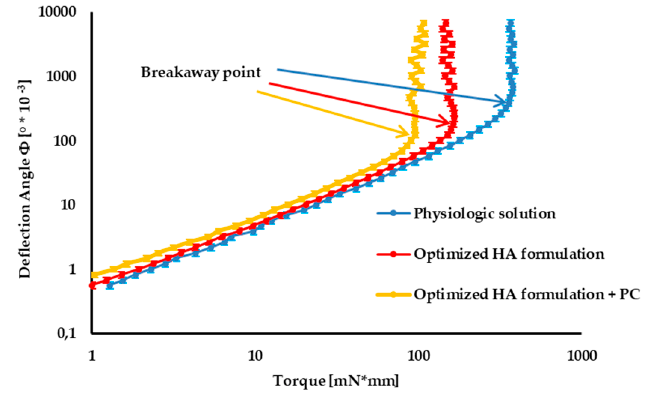
Figure 6. Comparison of tribology profiles (mean values ±s.d., n = 3).